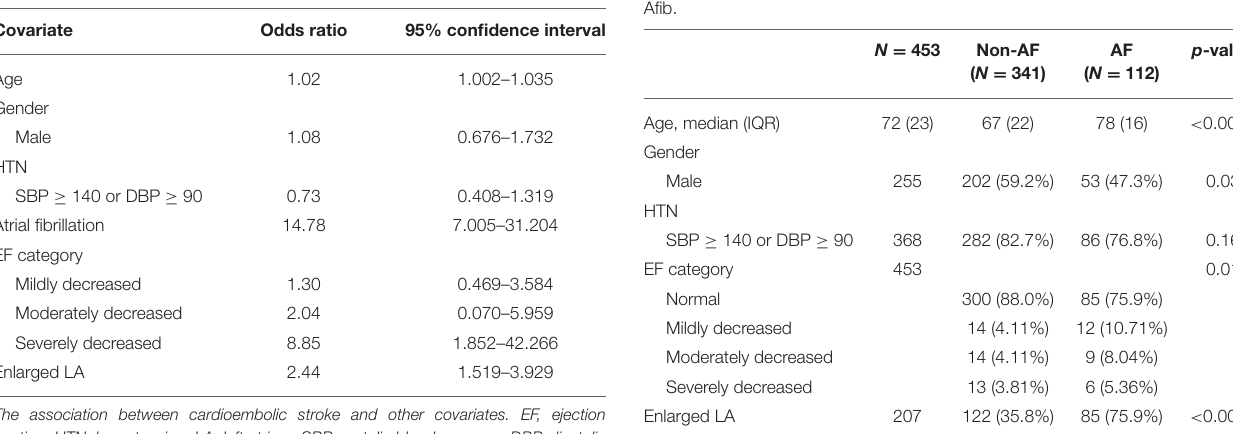
TABLE 2 | Multiple logistic regression model. TABLE 3 | Demographic characteristics of patients with Afib vs. those without